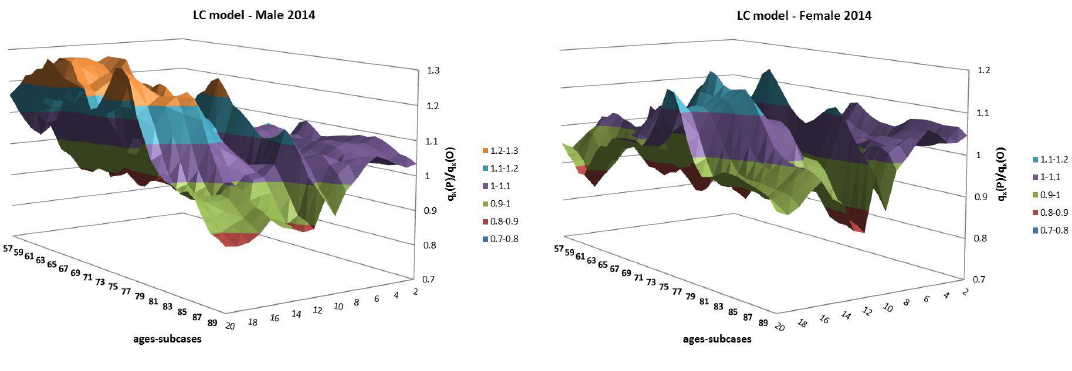
P x , t ratio q O x , t